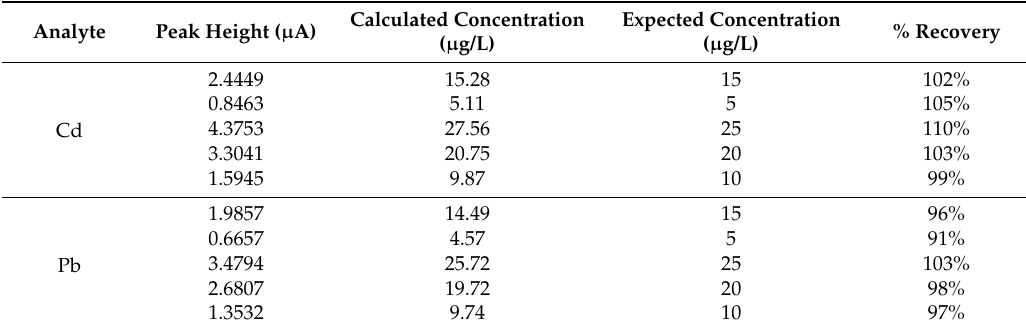
Table 2. Reference sample analyses in stopped-flow stripping voltammetry with external calibration. Flow = 1.0 mL/min; Preconcentration time = 60 s.